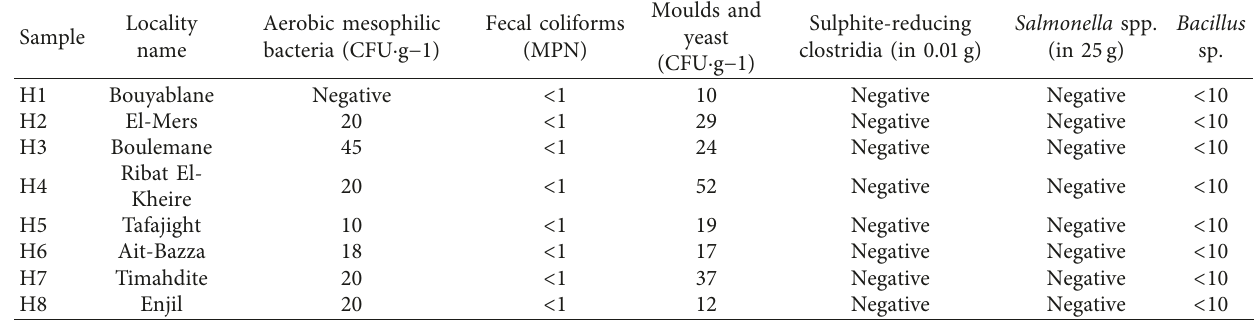
Table 6: Microbiological